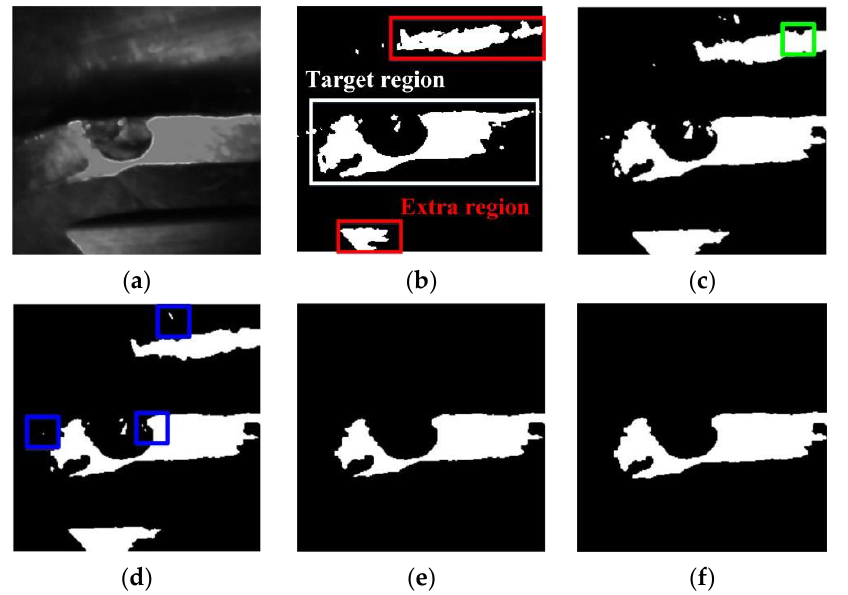
Figure 6. Segmentation and morphological operations of flank face image: ( a ) Preprocessed image; ( b ) Binarized image; ( c ) Hole filling; ( d ) Erosion; ( e ) Extraction of largest connected components; ( f )